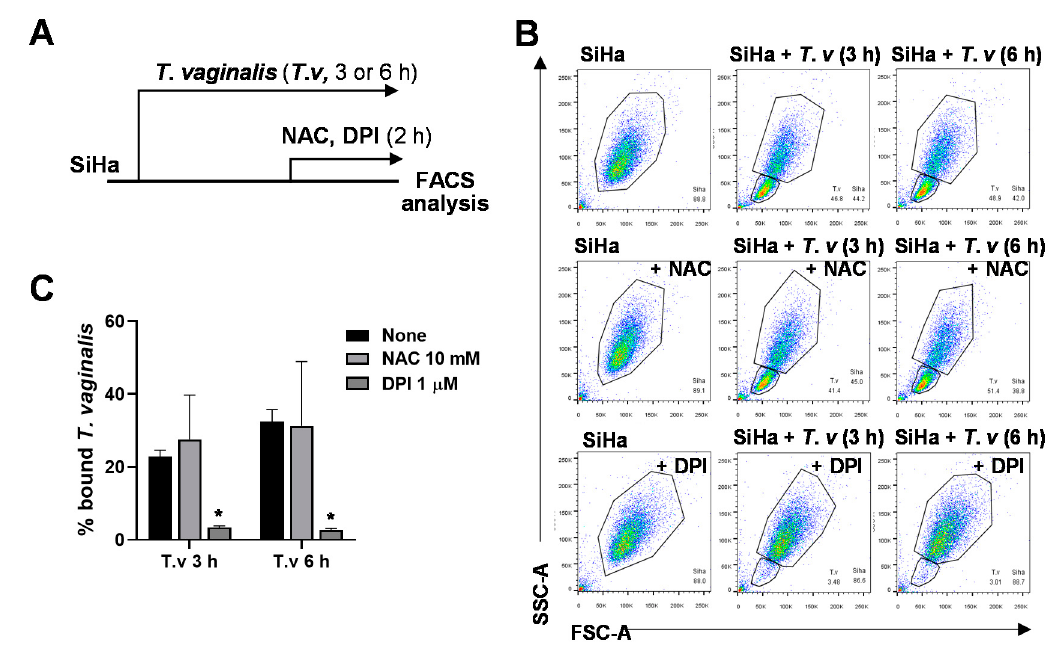
Figure 2. Antioxidant diphenyleneiodonium (DPI) reduced adherence of T. vaginalis to SiHa cells. ( A ) Experimental scheme: SiHa cells were infected with T. vaginalis for 3 or 6 h and treated with 10 mM NAC and 1 µ M DPI for the last 2 h. Attached cells were analyzed by flow cytometry. ( B ) Representative flow cytometry profile. ( C ) Bound T. vaginalis levels were quantified from flow cytometry data ( n = 3). Statistical difference by one-way ANOVA compared with no treatment controls (None). Mean ± SD, * p < 0.05. Data are representative of at least three independent experiments.